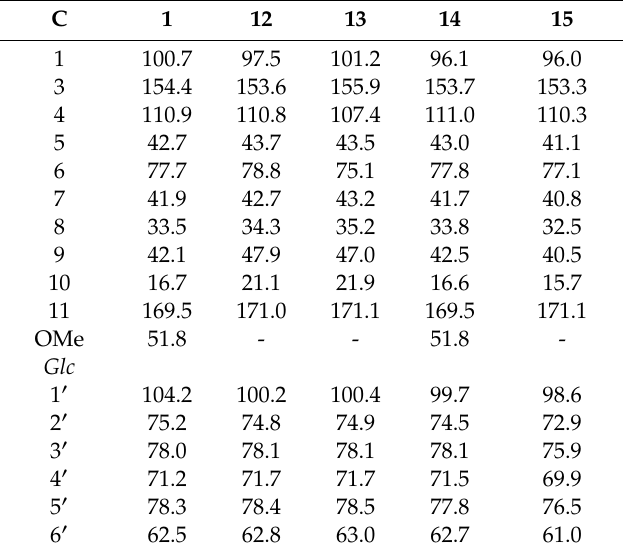
Table 2. 13 C-NMR data of Nepetamoside a ( 1 ), 6 β -dihydrocornic acid ( 12 ) b , 6 α -dihydrocornic acid ( 13 ) b , penstemonoside ( 14 ) b and 8-deoxyshanzhiside ( 15 )